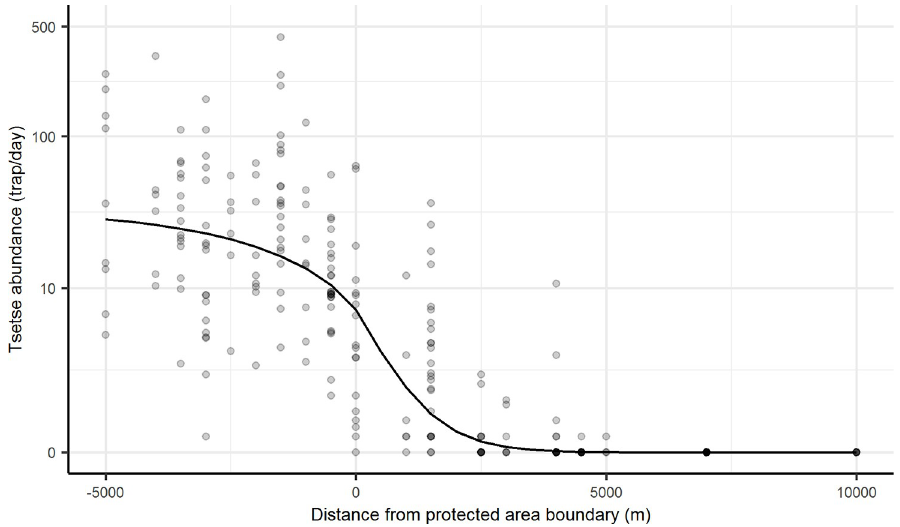
Fig 2. Modelled decline in tsetse abundance across the wildlife-livestock interface. Model fitted by nonlinear least squares regression to mean daily tsetse caught per trap across three surveys in 2015. Negative distances on x axis indicate inside wildlife areas where no additional mortality was modelled. The y axis is on log 10 scale. Darker points indicate samples from multiple traps at the same distance.